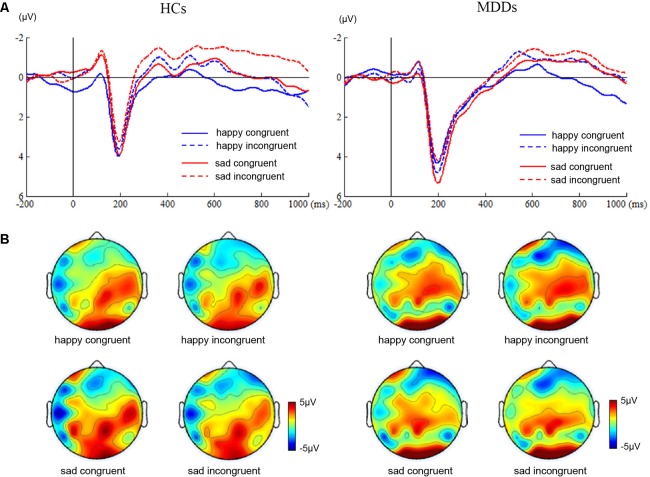
ERP waveforms and scalp topographies of N450. The waveforms were averaged across AF3, AF4, FP1, FP2, F5, and F6 to reflect the N450 ANOVA findings (A). The corresponding scalp topographies elicited by the target congruent stimuli and incongruent stimuli were obtained for a 20-ms long time interval around the latencies of the N450 peaks (B).